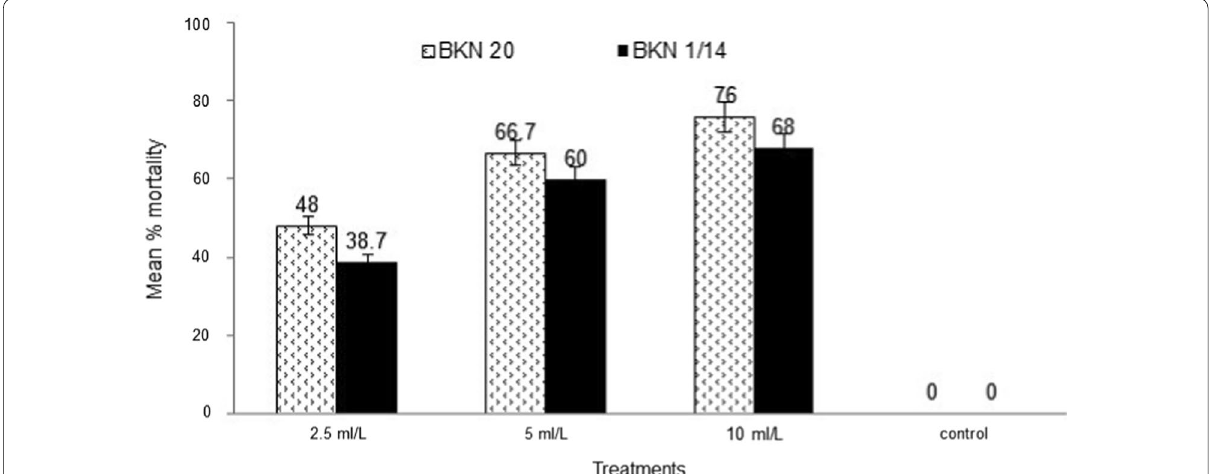
Fig. 1 In vitro bioassay of BKN 20 and BKN 1/14 isolates of B. bassiana against H. theivora nymphs. Values represent the mean of five replications SE after 5 days. The two isolates did not show any significant difference in efficacy ( p > 0.05, n ±